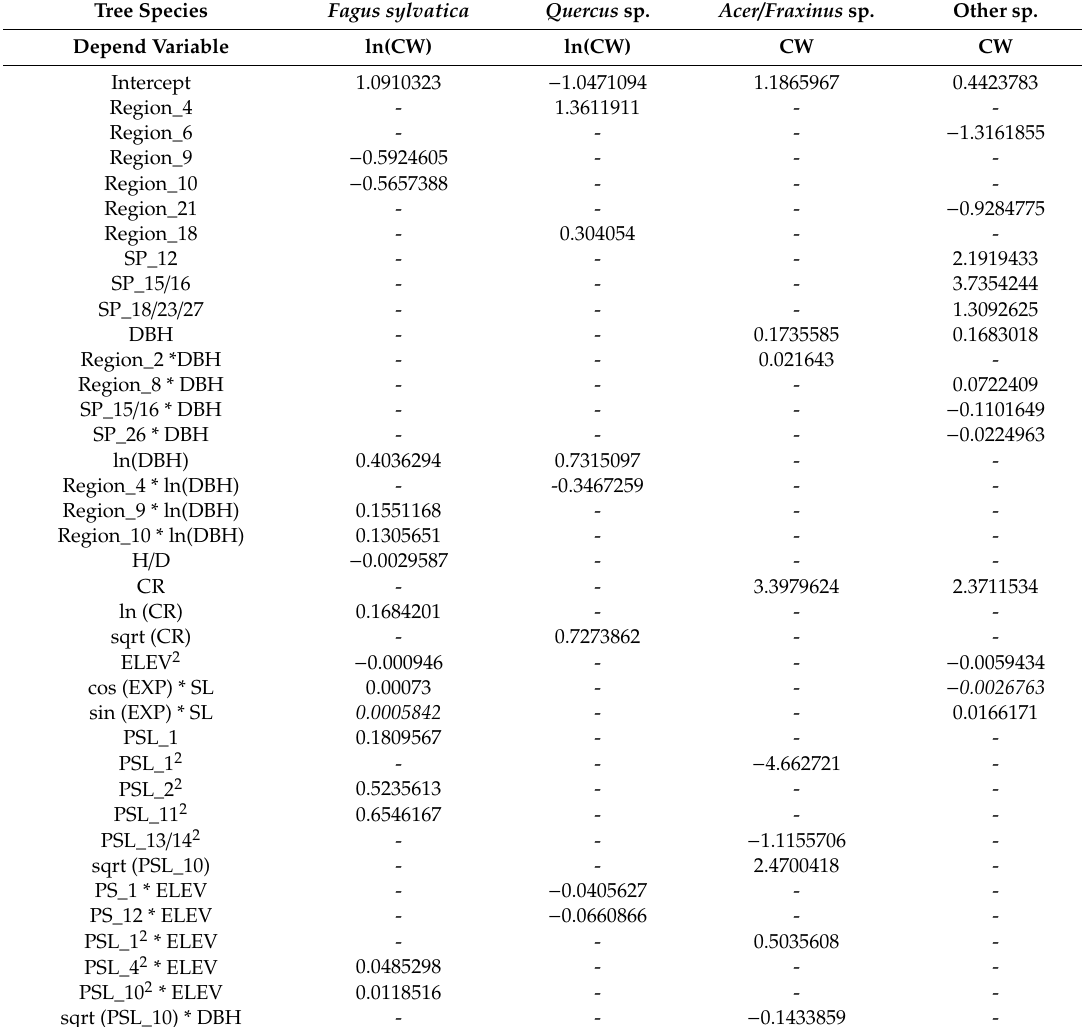
Table 5. Parameter estimates of the mixed-e ff ects CW models for broadleaf species. The dependent variable CW and DBH of the CW model for Maple and Ash species and for the remaining broadleaf species were not transformed. All shown estimates were significant ( p -value < 0.05), except values printed in